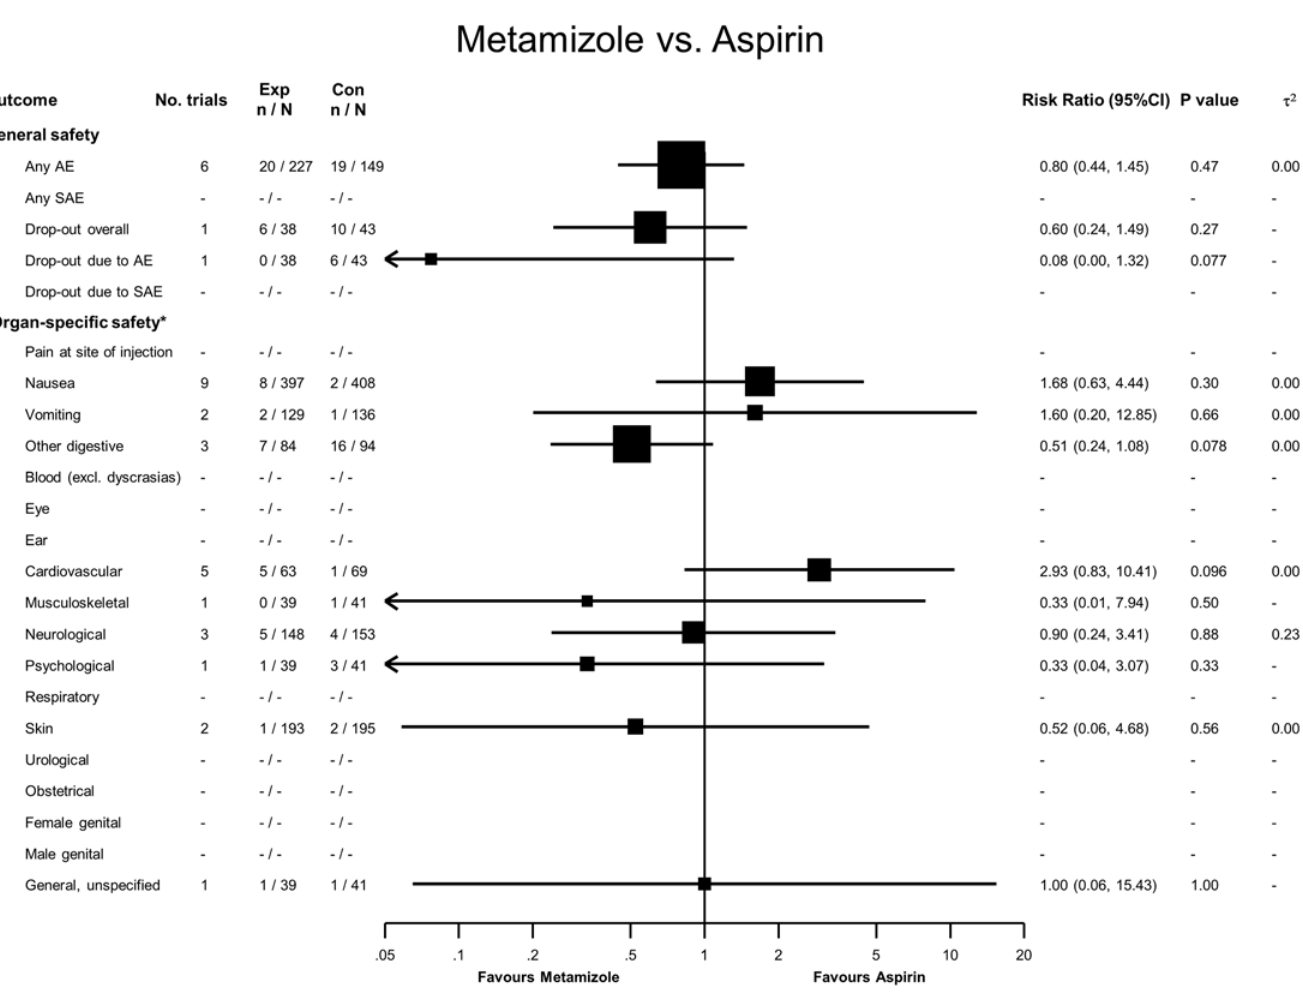
Fig 4. Forest plot — Metamizole versus Aspirin. Categories according to the International Classification of Primary Care (see Methods section and [13]). Results from single studies are of limited interpretability but are displayed for the sake of completeness. RR = risk ratio. AE = adverse events. SAE = serious adverse